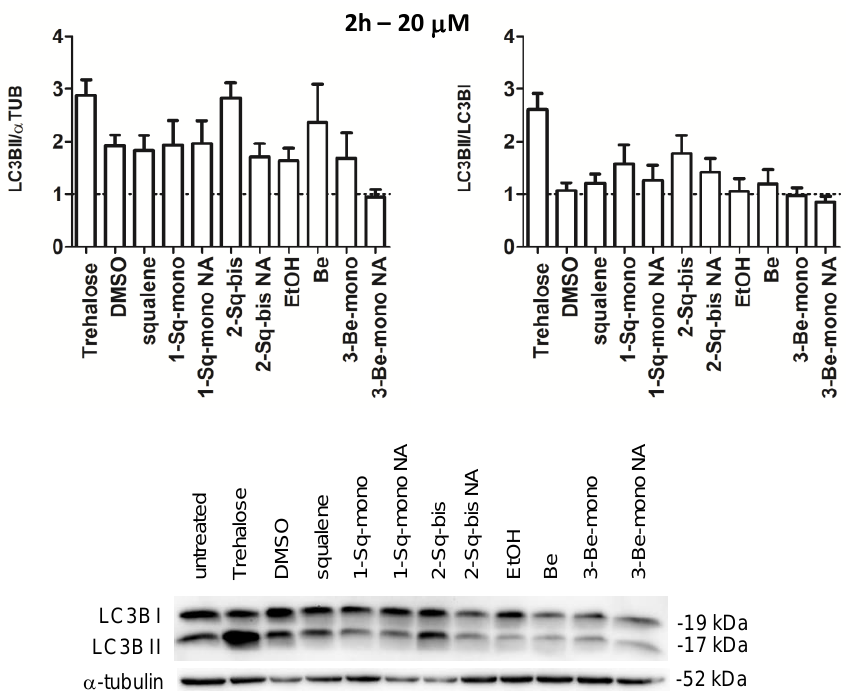
Figure 5. Autophagy induction on betulinic acid, squalene, 1-Sq-mono, 2-Sq-bis , 3-Be-mono , mono-Sq-NA1 , bis-Sq-NA2 and mono-Be-NA3 . LC3BII amount ( left ), LC3BII/LC3BI ratio ( right ), 2 h/20 M, trehalose = 100 mM).